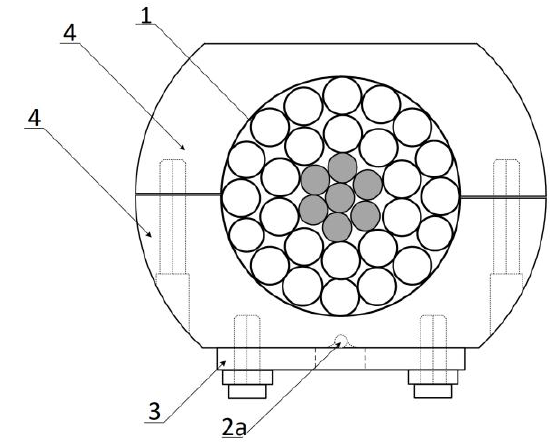
Figure 3. The cross-section of the sensing head of the power line sag measurement system where: 1, 2a, 3, and 4 are elements equivalent to those shown in Figure 2.